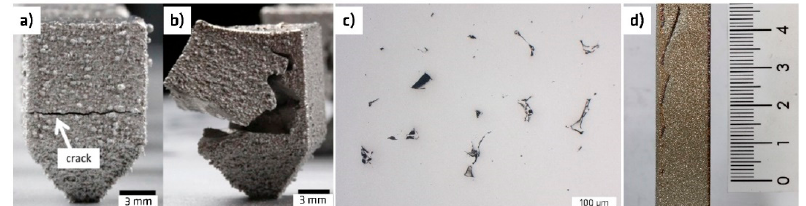
Figure 1. Photographs of characteristic defects in L-PBF (laser powder bed fusion): ( a ) and ( b ) delamination and cracks [9] ( c ) voids; ( d ) surface defects.